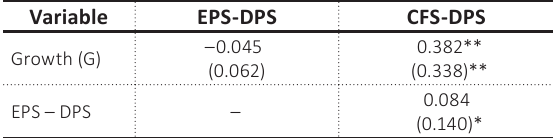
Table 2. Pearson (Spearman) correlation